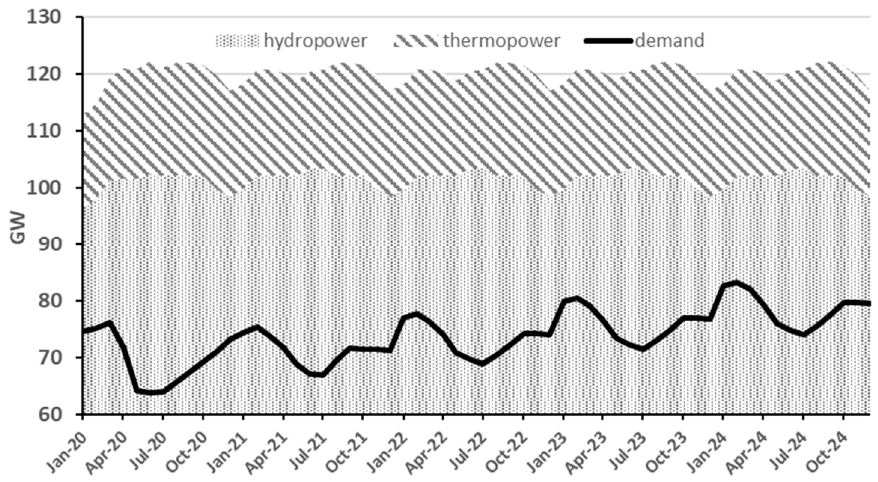
Figure 10. Power availability and